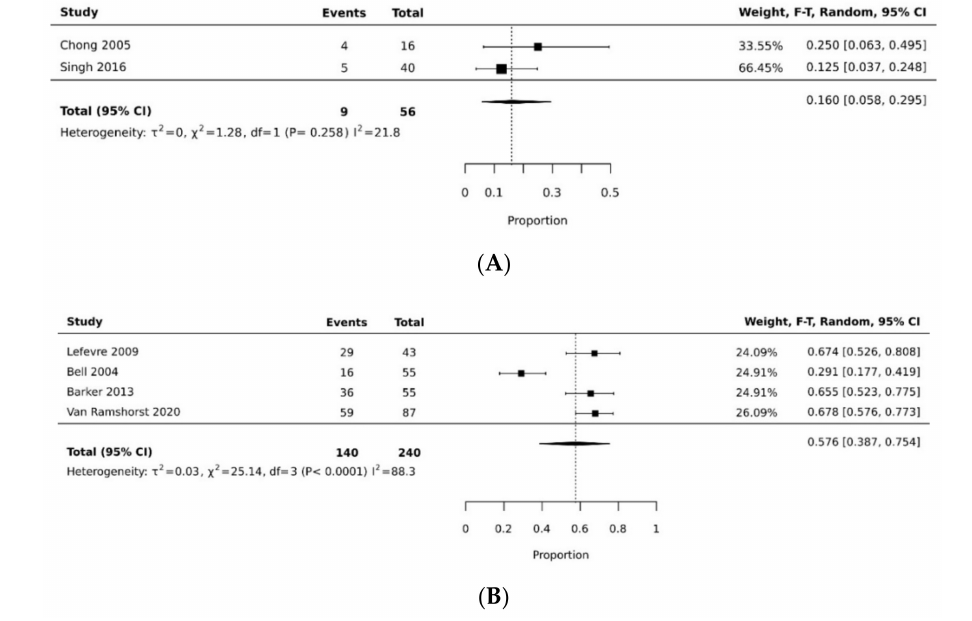
Figure 2. ( A ) Forest plot of gracilis overall donor site complication rate [21,35]. ( B ) Forest plot of VRAM overall donor site complication rate [11,27,29,32]. Table 3. Comparison of clinical outcomes between VRAM and